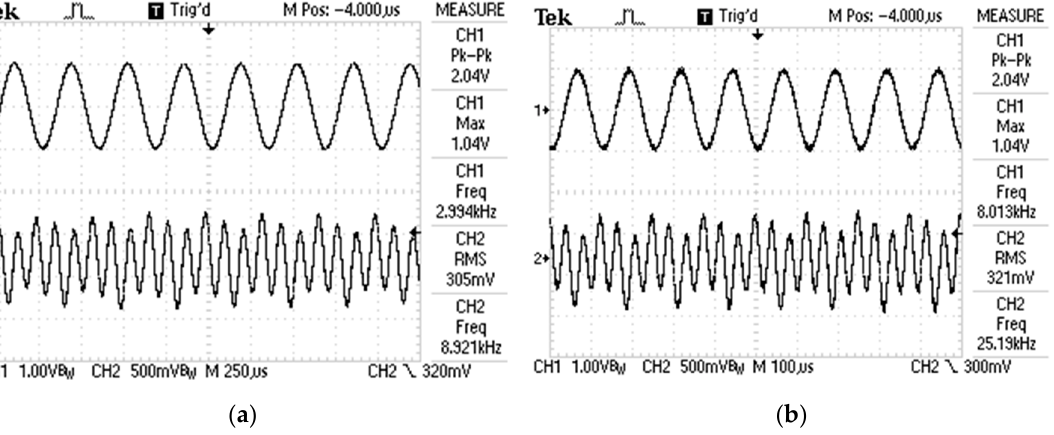
Figure 6. Input waveforms—CH1 and output waveforms—CH2 of the FPAA-based programmable analog circuit for the reference thin-film sample: ( a ) at input frequency equal to 3 kHz; ( b ) at input frequency equal to 8 kHz.